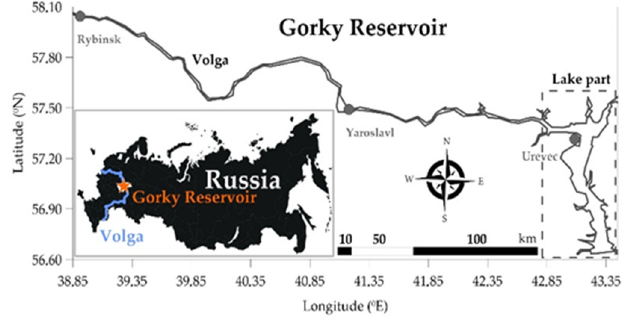
Figure 1. The Gorky Reservoir map.